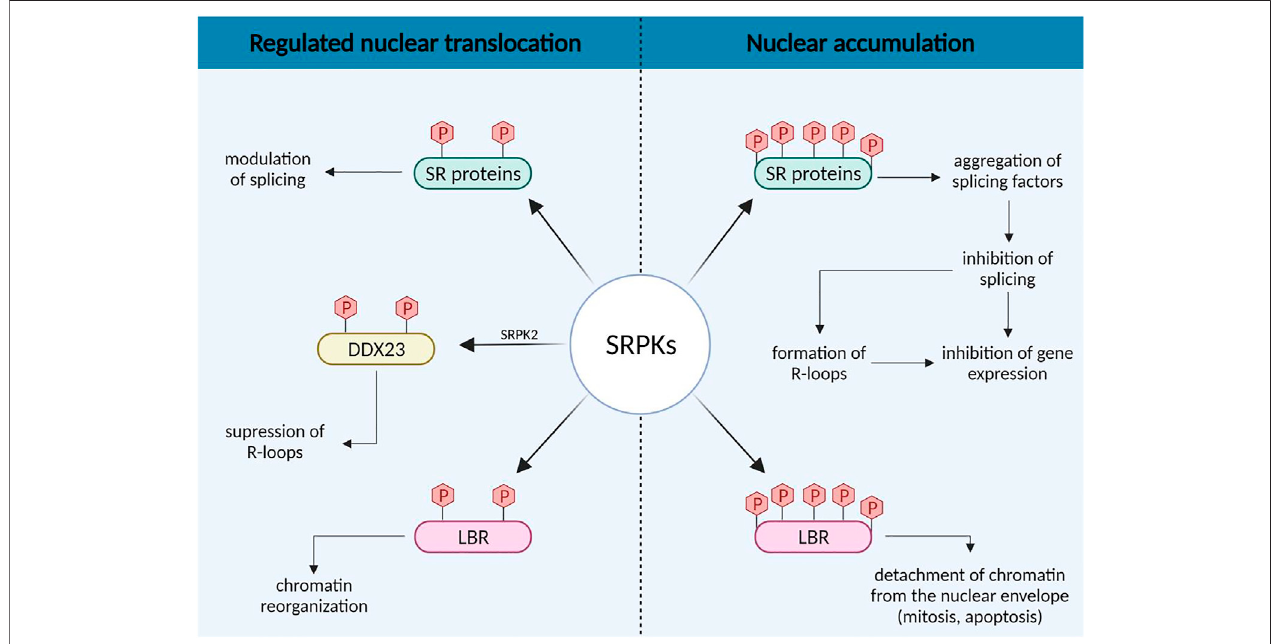
FIGURE 2 | Concentration-dependent effects of SRPKs on splicing regulation and chromatin